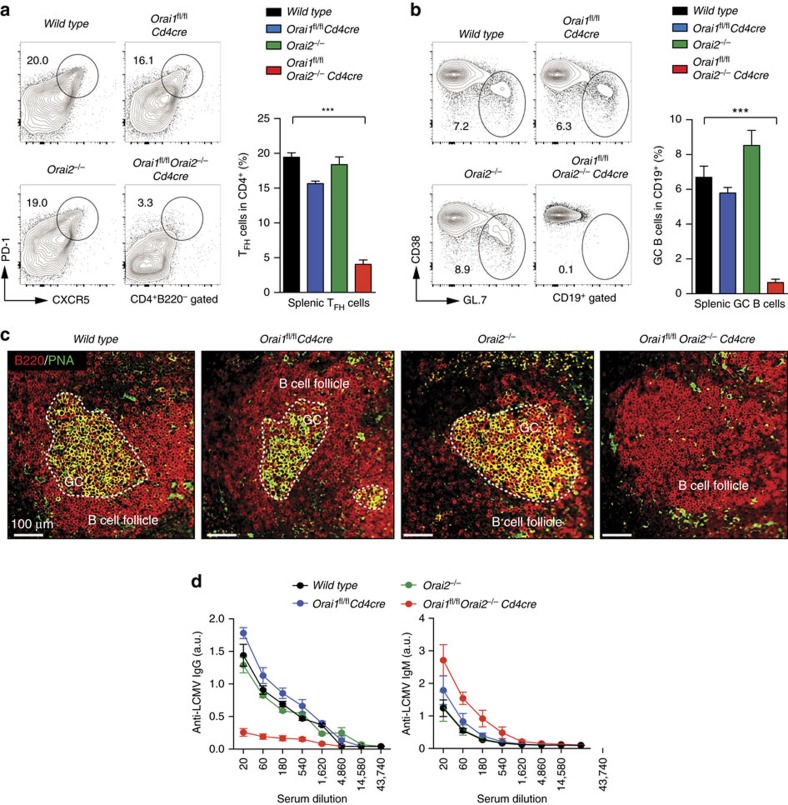
Humoral immunity requires both ORAI1 and ORAI2 in TFH cells.(a,b) Analysis of CD4+CXCR5hiPD-1hi TFH cells (a) and CD19+CD38−GL.7+ GC B cells (b) in spleens of WT, Orai1fl/flCd4cre, Orai2−/− and Orai1fl/flOrai2−/−Cd4cre (DKO) mice 10 days after LCMV infection by flow cytometry; means±s.e.m. of four to eight mice. (c) Representative immunofluorescence of GCs in WT, Orai1fl/flCd4cre, Orai2−/− and DKO mice 10 days after LCMV infection; PNA (green) and B220 (red). Scale bar, 100 μm. (d) Analysis of LCMV-specific IgM and IgG levels in the sera of WT, Orai1fl/flCd4cre, Orai2−/− and DKO mice 10 days after LCMV infection; means±s.e.m. of four to six mice. *P<0.05; **P<0.005; ***P<0.001 in (a,b) using unpaired Student's t-tests.